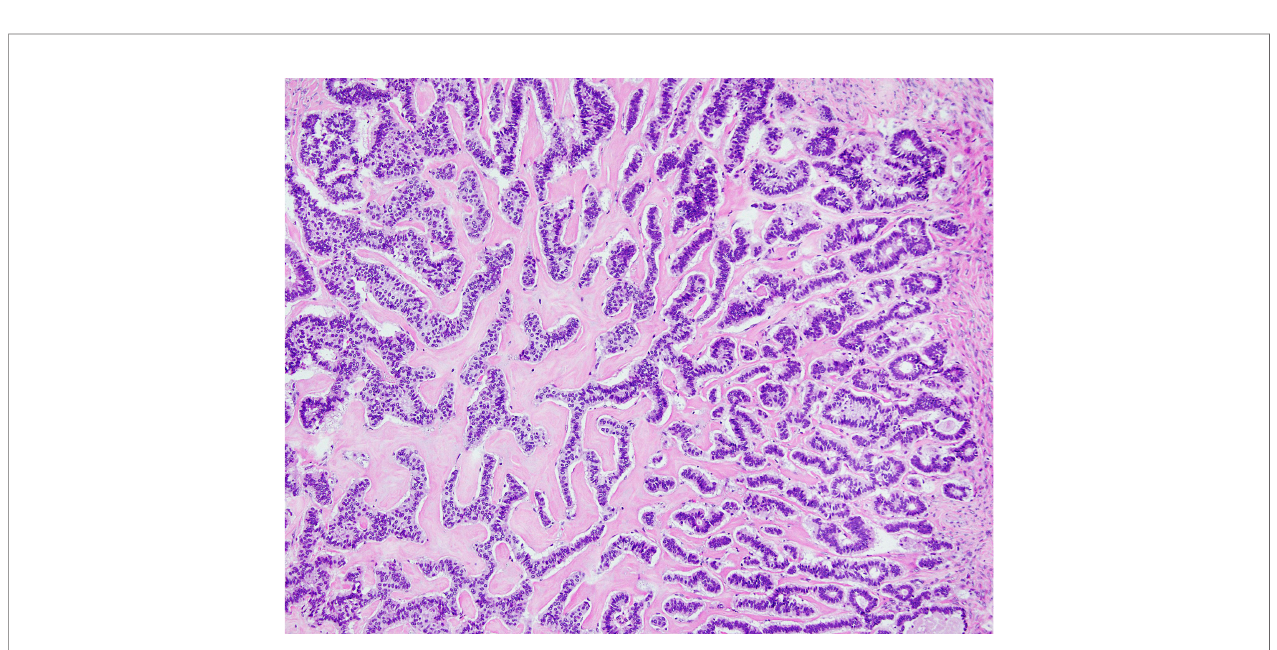
FIGURE 4 | NET foci in teratoma. Hematoxylin-eosin staining, zoom 10x. Long parallel ribbons and small islands and nests of cells with eosinophilic cytoplasm and oblong nuclei oriented perpendicular to main axis of